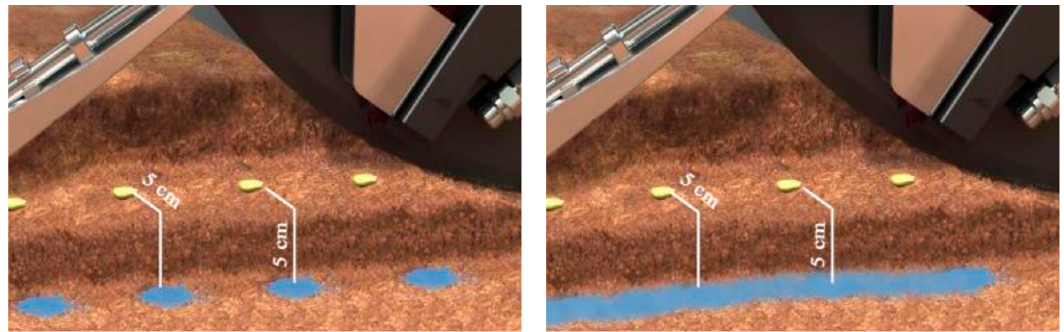
Figure 2. Applied methods of applying liquid starter fertilizer to the point and the belt.